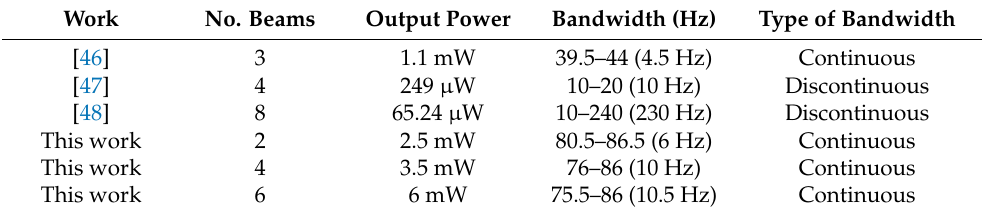
Table 2. Performance parameters comparison of different arrays of piezoelectric harvesters.